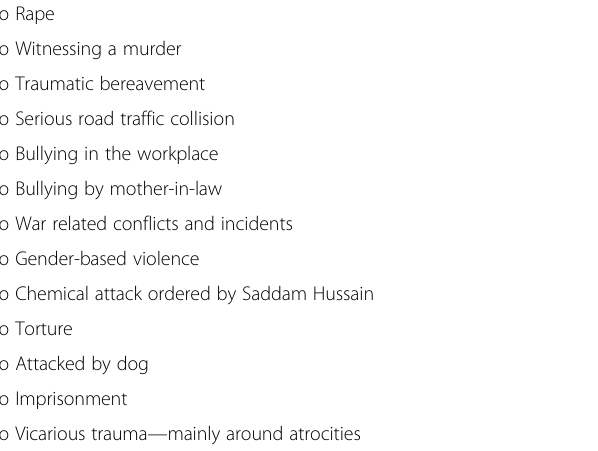
Table 5 Major themes of target trauma memories used for B2T protocol ( N = 91)